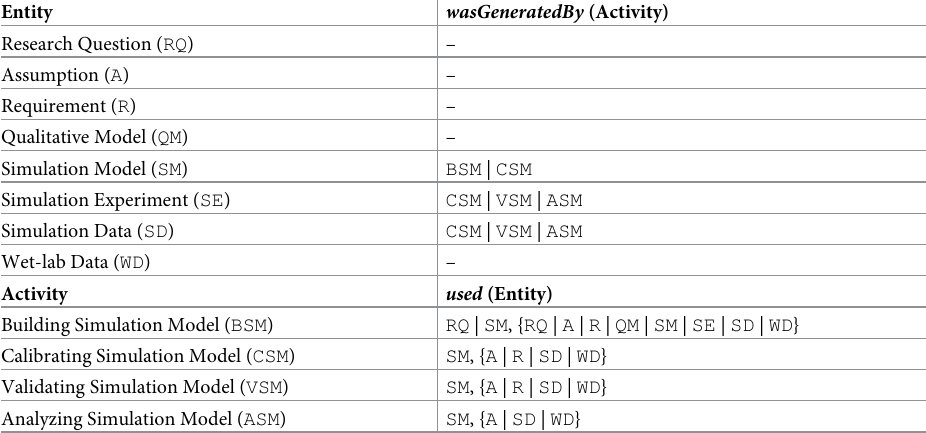
Table 2. Entities, activities and allowed relations in our PROV-DM